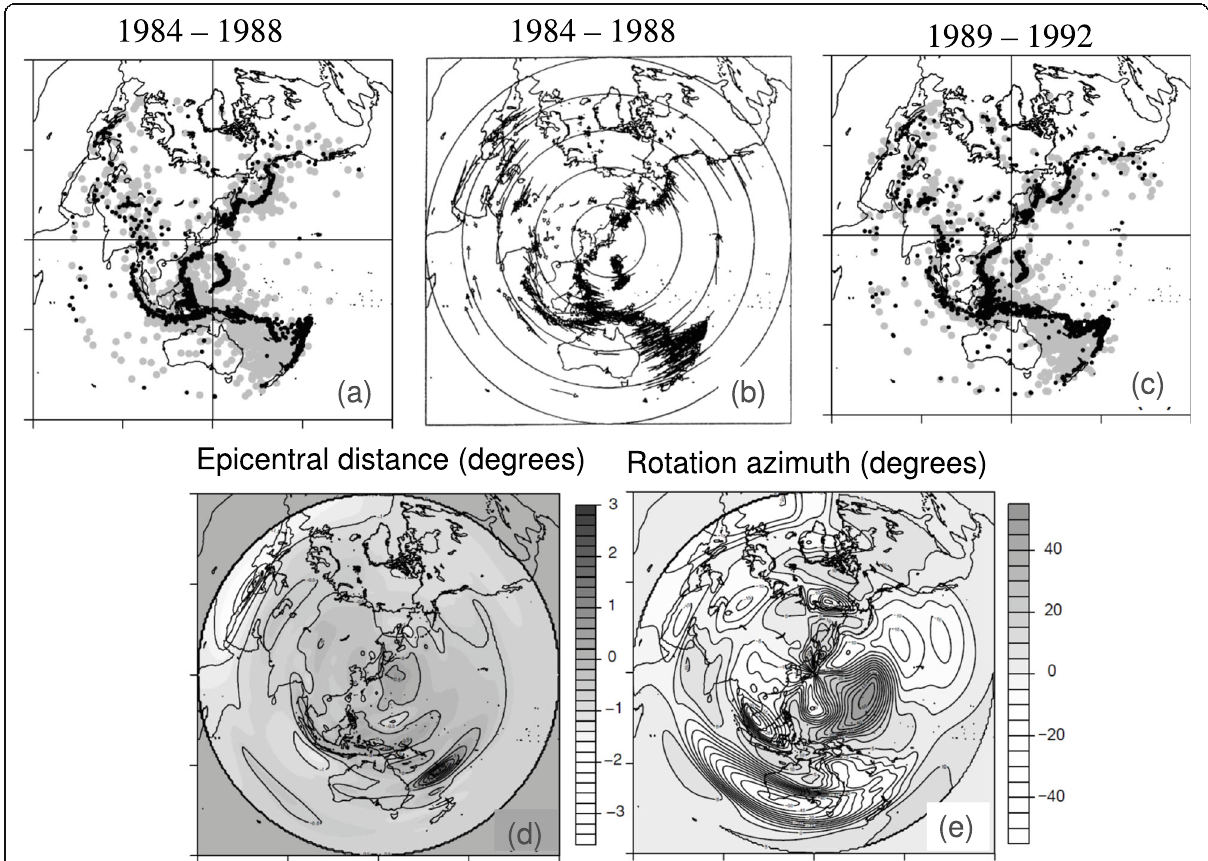
Fig. 7 Correction of the epicenter locations determined by the local MSAS array for global earthquakes. Epicenter locations (gray disks) for earthquakes determined by MSAS; a earthquakes occurring in 1984 – 1988 and c earthquakes occurring in 1989 – 1992. The geographical world map is drawn by a polar coordinate system whose center is the location of the MSAS origin in central Japan. Black disks in a indicate USGS locations and b difference of epicenter locations of the same earthquake. An arrow indicates the shift from the MSAS location to the USGS location, provided that the differences of epicentral distance and azimuth are within 2 o and 25 o , respectively. These are used to minimize by the sum of least squares under a smoothness constraint (see text). The black disks in c are compensated locations from the MSAS data (gray disks) in c by the estimated bias functions f and g , shown in d and e , respectively. Contour plots in the panels d and e show the bias functions f for epicentral distance and g for azimuth in Eqs. (10) and (11), respectively, which are estimated using the data during 1984 – 1988 in Fig. 7a. The function f varies from − 3.5° to 2.5° in the angular distance, and the contour interval is 0.5°. The function g varies from − 45.0° to 50.0°, and the contour interval is 5.0°. Areas of negative function values are